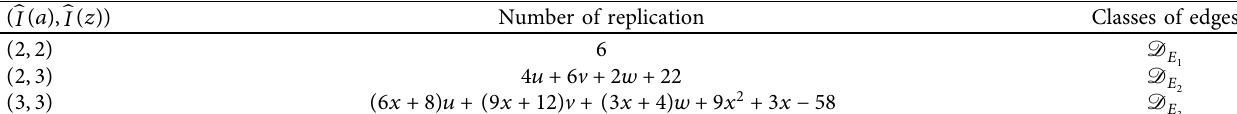
Table 2: Edge partition of the coronoid system C [ u,v, w,x ] on the basis of degrees of terminal vertices of each edge. 1 ( 􏽢 I ( a ) , 􏽢 I ( z )) Number of replication Classes of